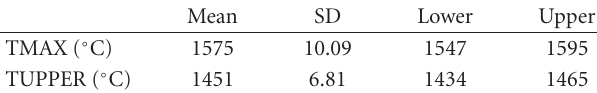
Figure 18: Maximum fuel temperature evolutions for di ff erent val- ues of DHR valve stem position (1DHR loop available).